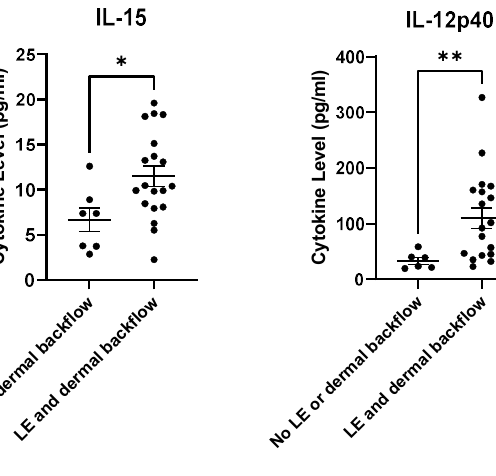
compared to subjects with no clinical BCRL or dermal backflow. * p ≤ 0.05, ** p ≤ 0.01, *** p ≤ 0.001. pre-ALND in subjects with both clinical BCRL/LE and dermal backflow at 12-months post-RT com-